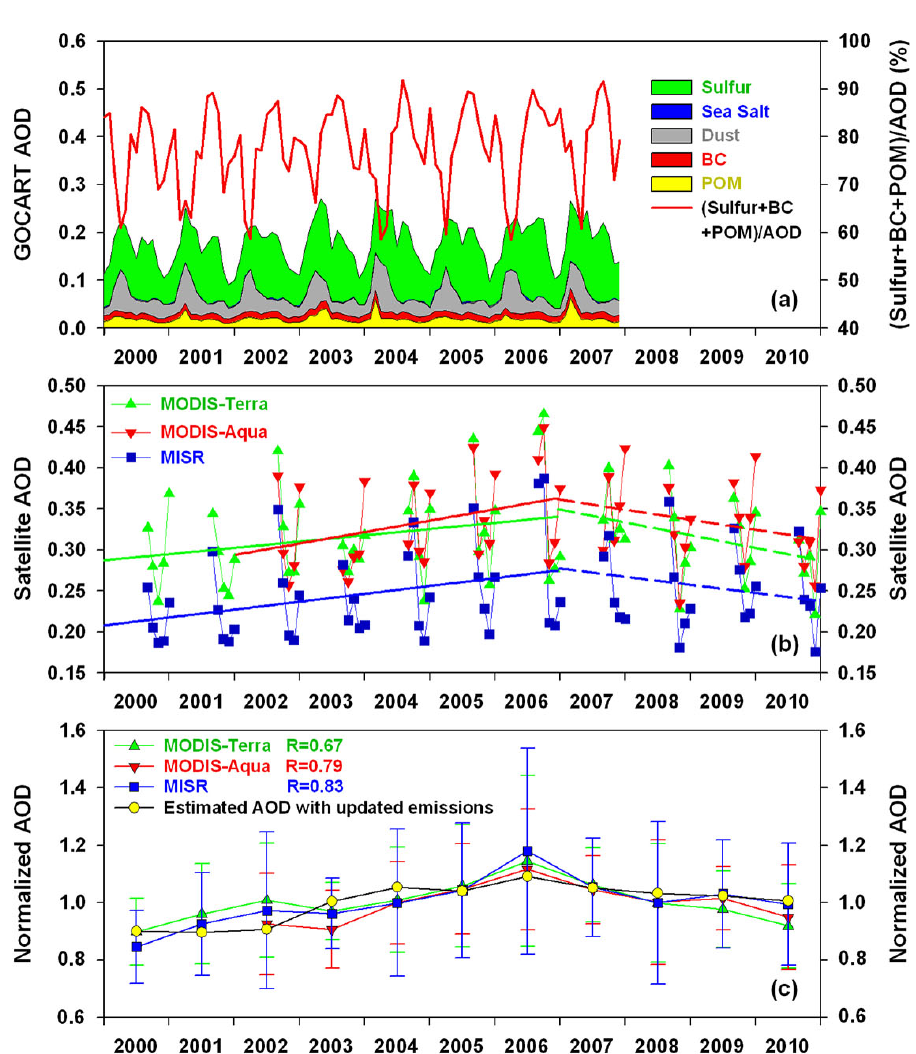
Fig. 10. AOD from GOCART model simulations and the MODIS (Terra and Aqua) and MISR satellite instruments over eastern central China (latitude < 45 ◦ N, longitude > 100 ◦ E). (a) Monthly variation of GOCART AOD and the combined contribution from sulfate, BC, and POM to total AOD during 2000–2007. (b) Monthly mean variability of satellite AOD retrievals during September to January 2000–2010. Solid and dashed lines represent the linear tendencies before and after 2006, respectively. (c) Trend of estimated AOD due to SO 2 , BC, and OC emissions, and evolutions of satellite AOD averaged between September and January during 2000–2010. R values shown are the correlation coefficients of each satellite AOD with estimated AOD. Error bars express one standard deviation of the monthly